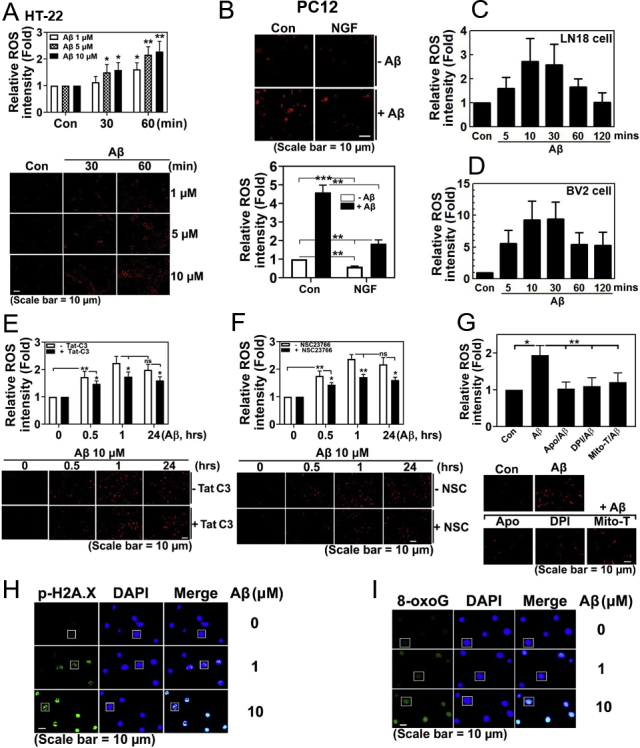
Aβ induces superoxide production. Dihydroethidium was used to directly measure superoxide levels in live cells (panels A–F). (A) Various concentrations of fAβ were treated to HT22 cells for various periods and superoxide levels were determined (two-way ANOVA, p*< 0.05, **< 0.01, ***< 0.001). (B) PC12 cells were treated with Aβ (1 μM) for 24 h in the absence or presence of NGF (100 ng/ml), and superoxide levels were determined (two-way ANOVA, p*< 0.05, **< 0.01, ***< 0.001). (C) LN18 cells (astrocyte cell line) and (D) BV2 cells (microglial cell line) were treated with Aβ (1 μM) and superoxide levels were determined. (E) HT22 cells were pre-treated with Tat-C3 (1 μg/ml) or (F) with NSC23766 (50 μM) for 1 h, then treated with fAβ (10 μM) for 24 h, and superoxide levels were determined (two-way ANOVA, p*< 0.05, **< 0.01, ***< 0.001). (G) HT22 cells were pre-treated with apocynin (1 μM), DPI (10 μM), or Mito-TEMPOL (100 μM) for 1 h, then treated with fAβ (10 μM) for 24 h, and then superoxide levels were determined (one-way ANOVA, p*< 0.05, **< 0.01, ***< 0.001). (H,I) DNA damage by high concentration of Aβ (10 μM) was shown: (H) Uncropped image of cells shown in Fig. 5E; (I) Uncropped image of Fig. 5F.